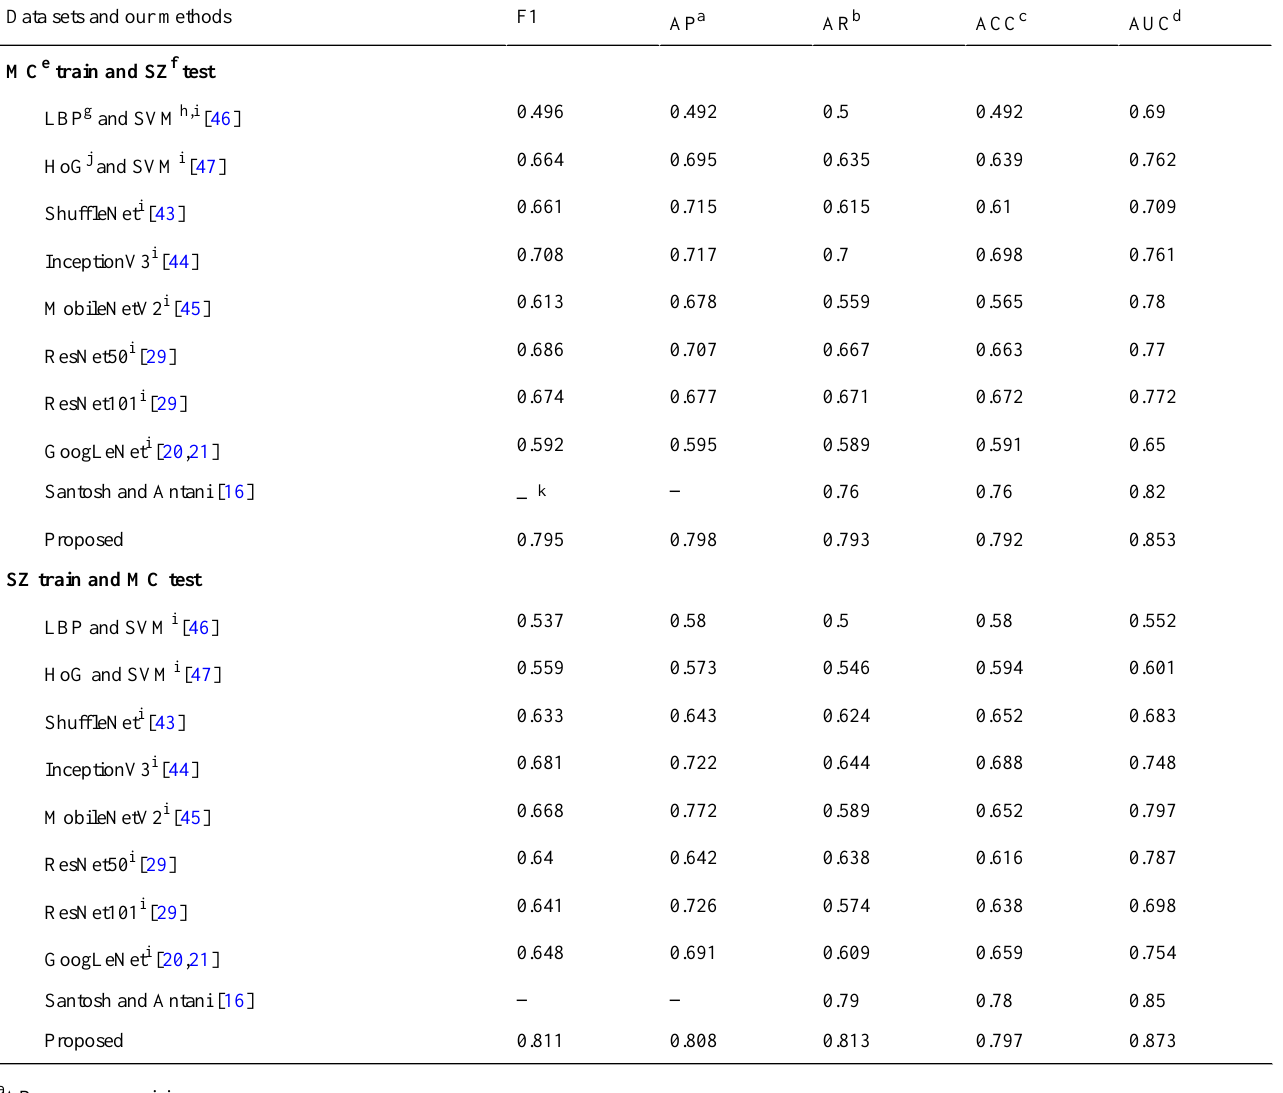
Table 6. Results of comparative performance analysis of our proposed method with various baseline methods for cross data